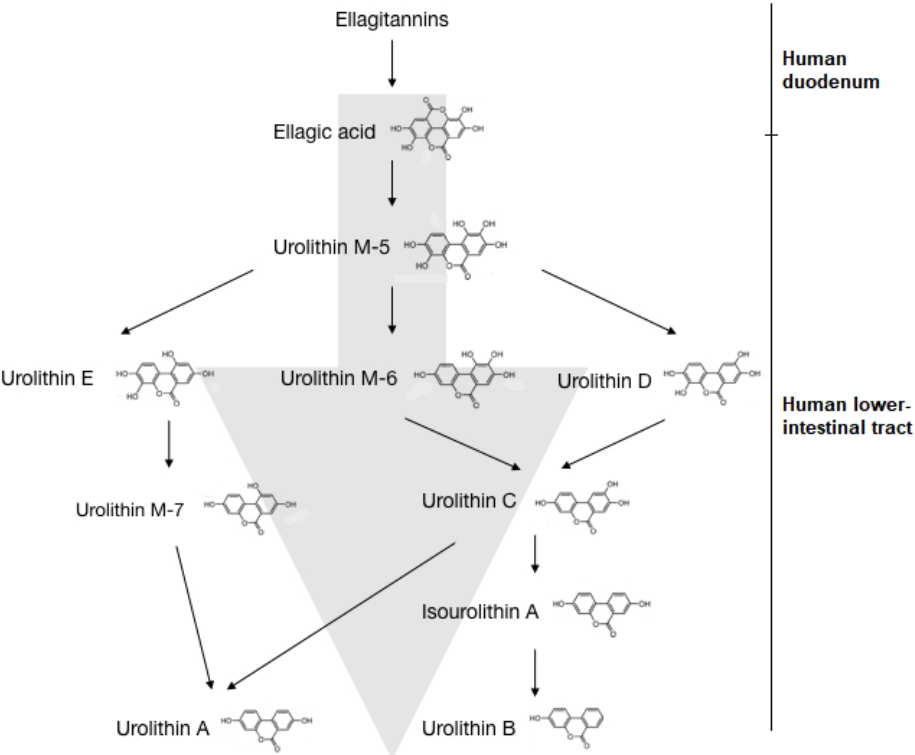
Figure 2. Bacterial transformation of ellagitannins into urolithin A and B in humans. The ETs in ingested food are converted to EA in the human duodenum. In the lower intestinal tract, EA is converted to urolithin M-5, which can be converted into the intermediates urolithin E, urolithin M-6 and urolithin D. Urolithin E converts to urolithin M-7, while urolithin M-6 and urolithin D give rise to urolithin C. Urolithin C converts to isourolithin A and urolithin B respectively. Alternatively, urolithin M-7 and urolithin C are converted to urolithin